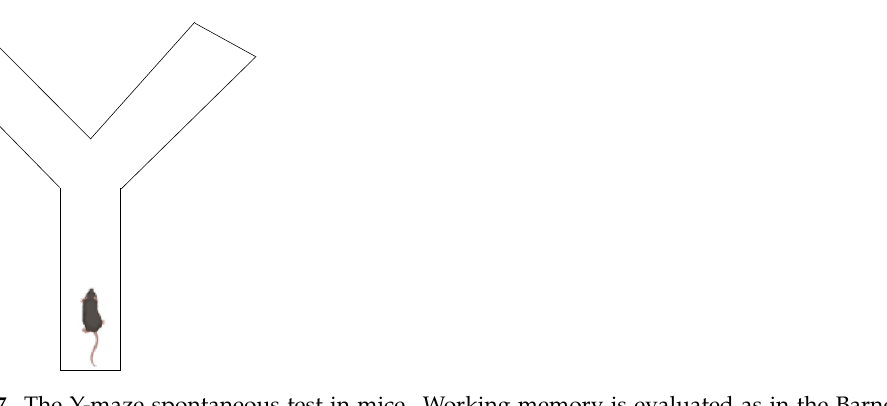
Figure 8. The Barnes maze test in mice. Different cues are given to the mouse to find an escape in the Barnes maze apparatus. Created with Biorender.com.